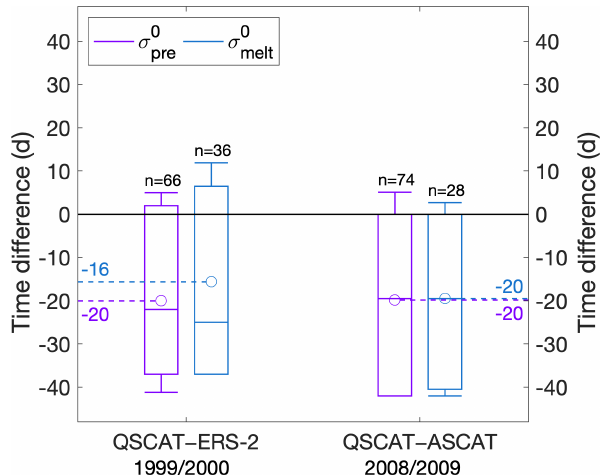
Figure 6. Averaged time differences between pre-melt and snowmelt onset dates retrieved from QSCAT and ERS/ASCAT at the different study locations on perennial sea ice for the overlap pe- riods 1999/2000 and 2008/2009, respectively. Negative (positive) differences indicate an earlier (later) transition detected from the Ku band. Boxes are the first and third quartiles. Whiskers display the 20th and 80th percentiles. Circles indicate mean, lines median